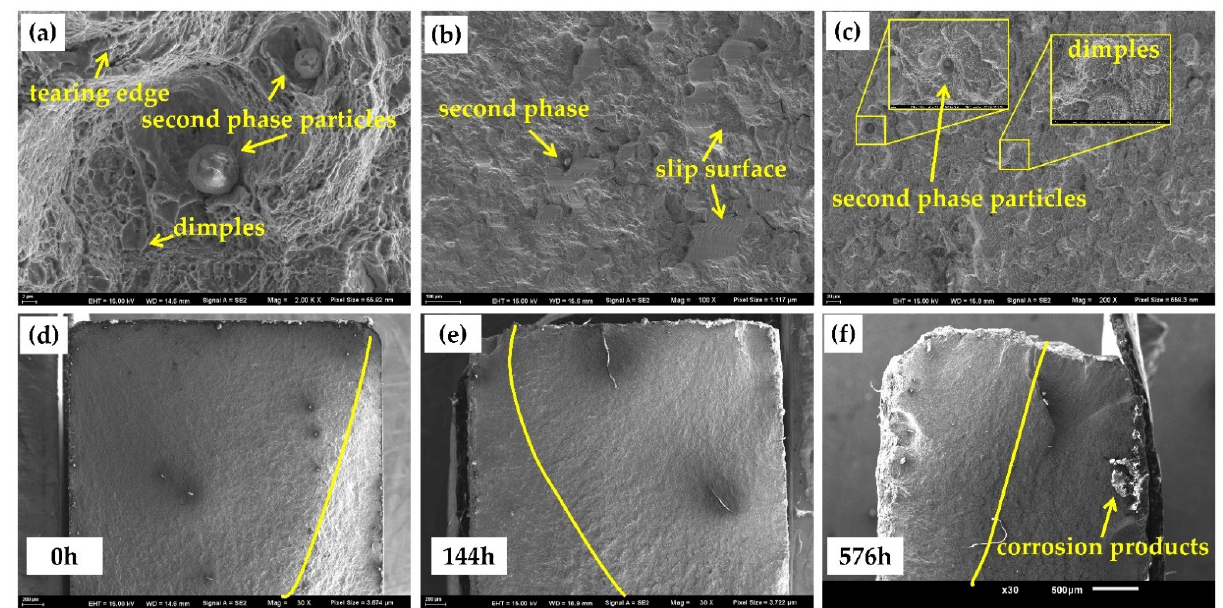
Figure 12. The microscopic morphology of the final rupture region: ( a – c ) micromorphological characteristics; ( d ) blank; ( e ) 144 h; ( f ) 576 h.